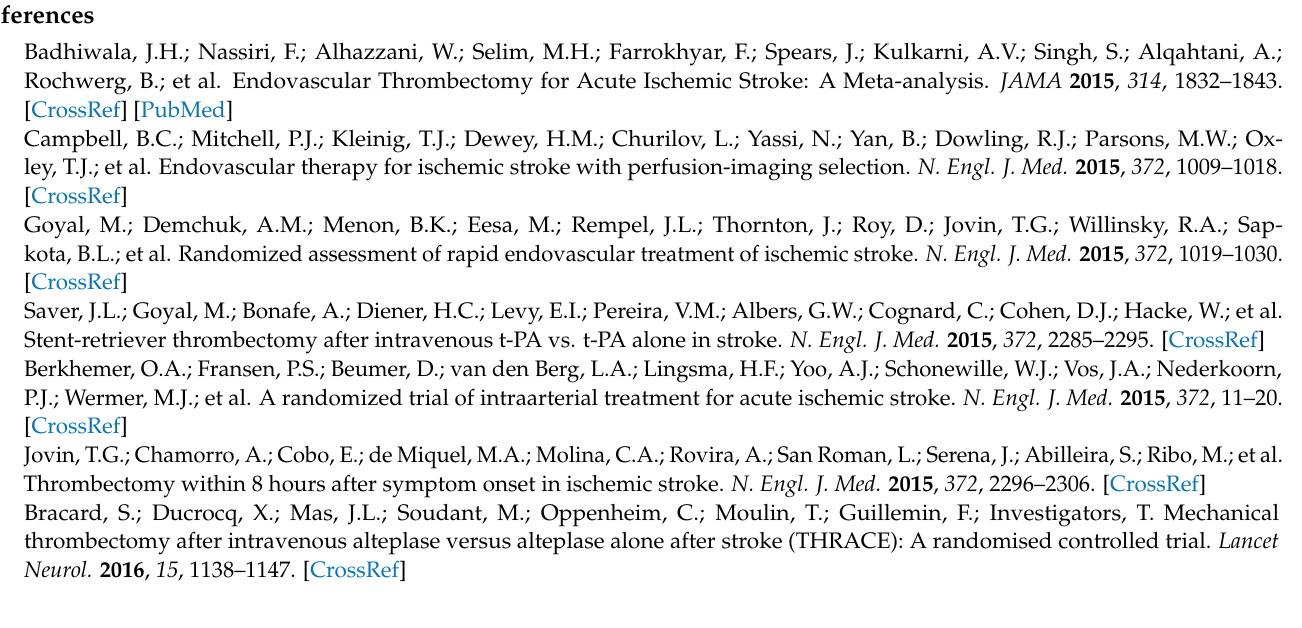
Table S3: Egger’s test for publication bias assessment of the included studies; Table S4: Jaded analysis for methodological quality/risk of bias and test for funding bias. References [6,15–38,44] are cited in the supplementary